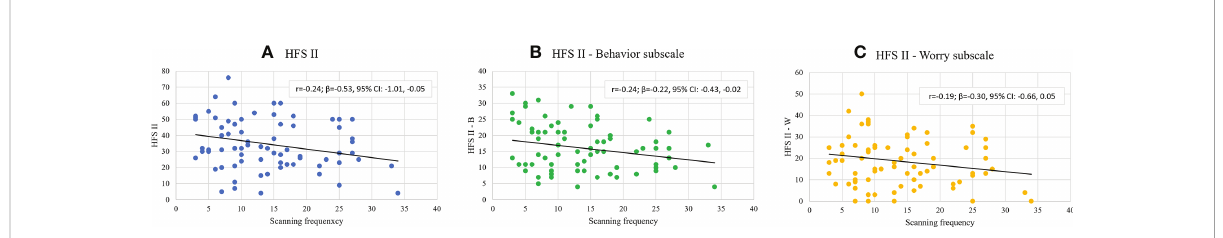
FIGURE 4 Fear of hypoglycemia by scanning frequency. (A) HFS II, (B) HFS II - Behavior subscale, (C) HFS II - Worry subscale. b - beta coef fi cient, r - Pearson correlation coef fi